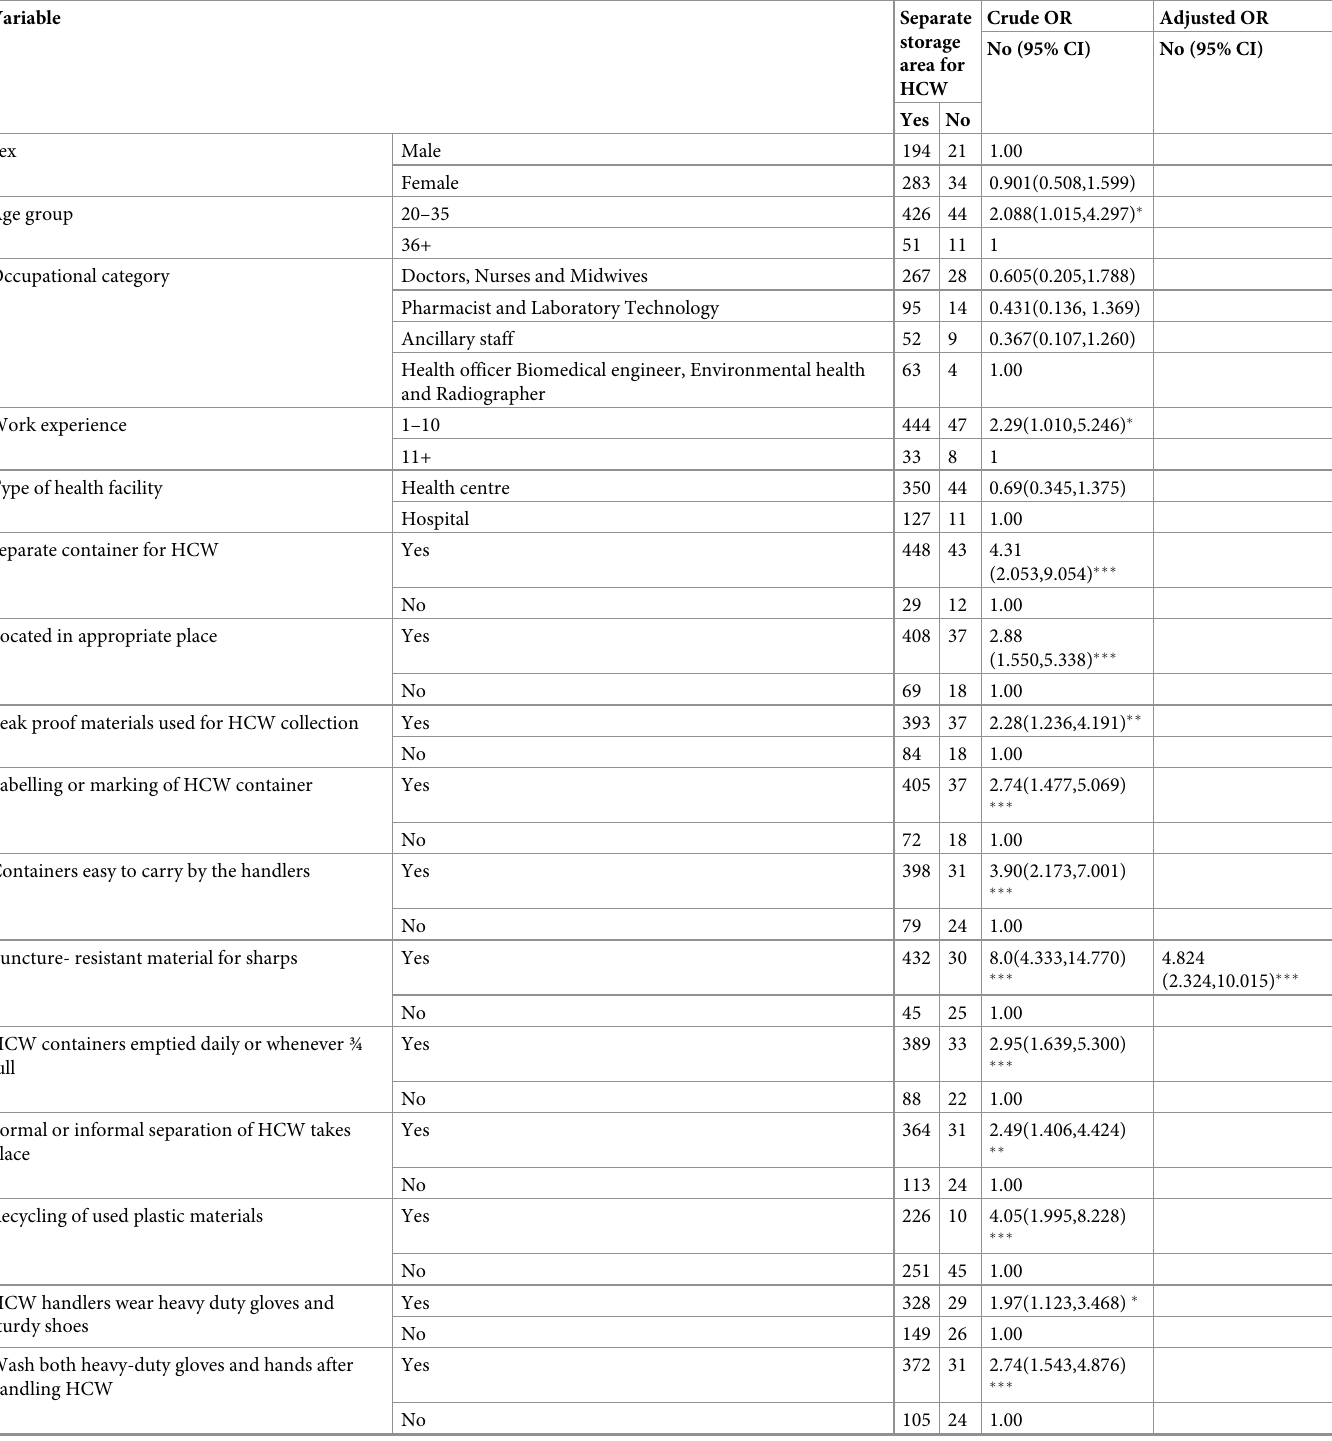
Table 17. Factors associated with HCW handling practice among HCW handlers in the study health facilities, Addis Ababa City Administration, February 2018.